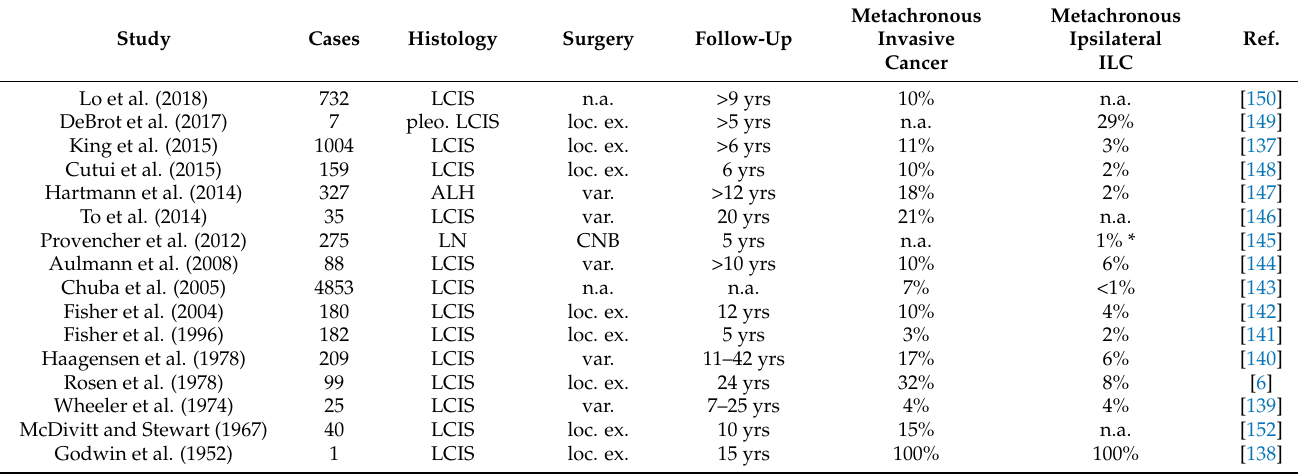
Table A3. Metachronous BC in patients diagnosed with pure LN and treated without mastectomy.